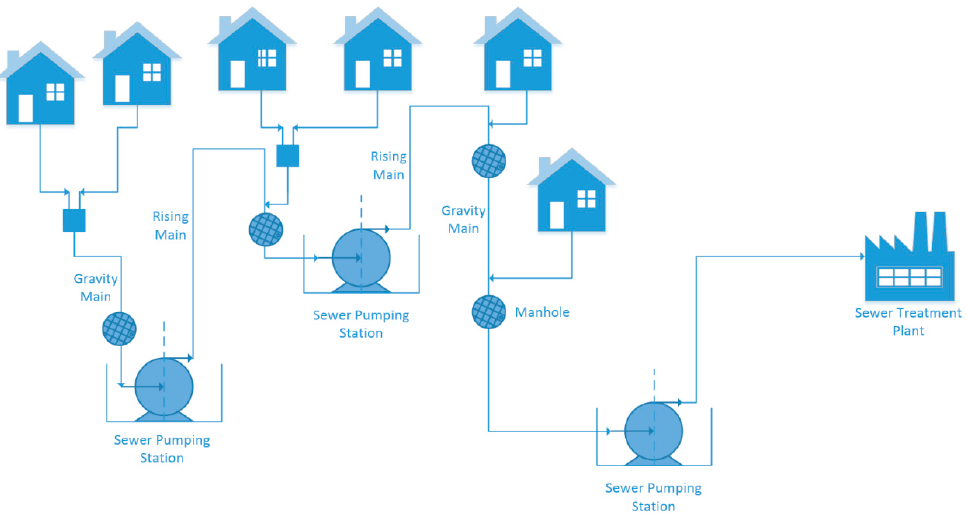
Figure 1. A typical sewer network.